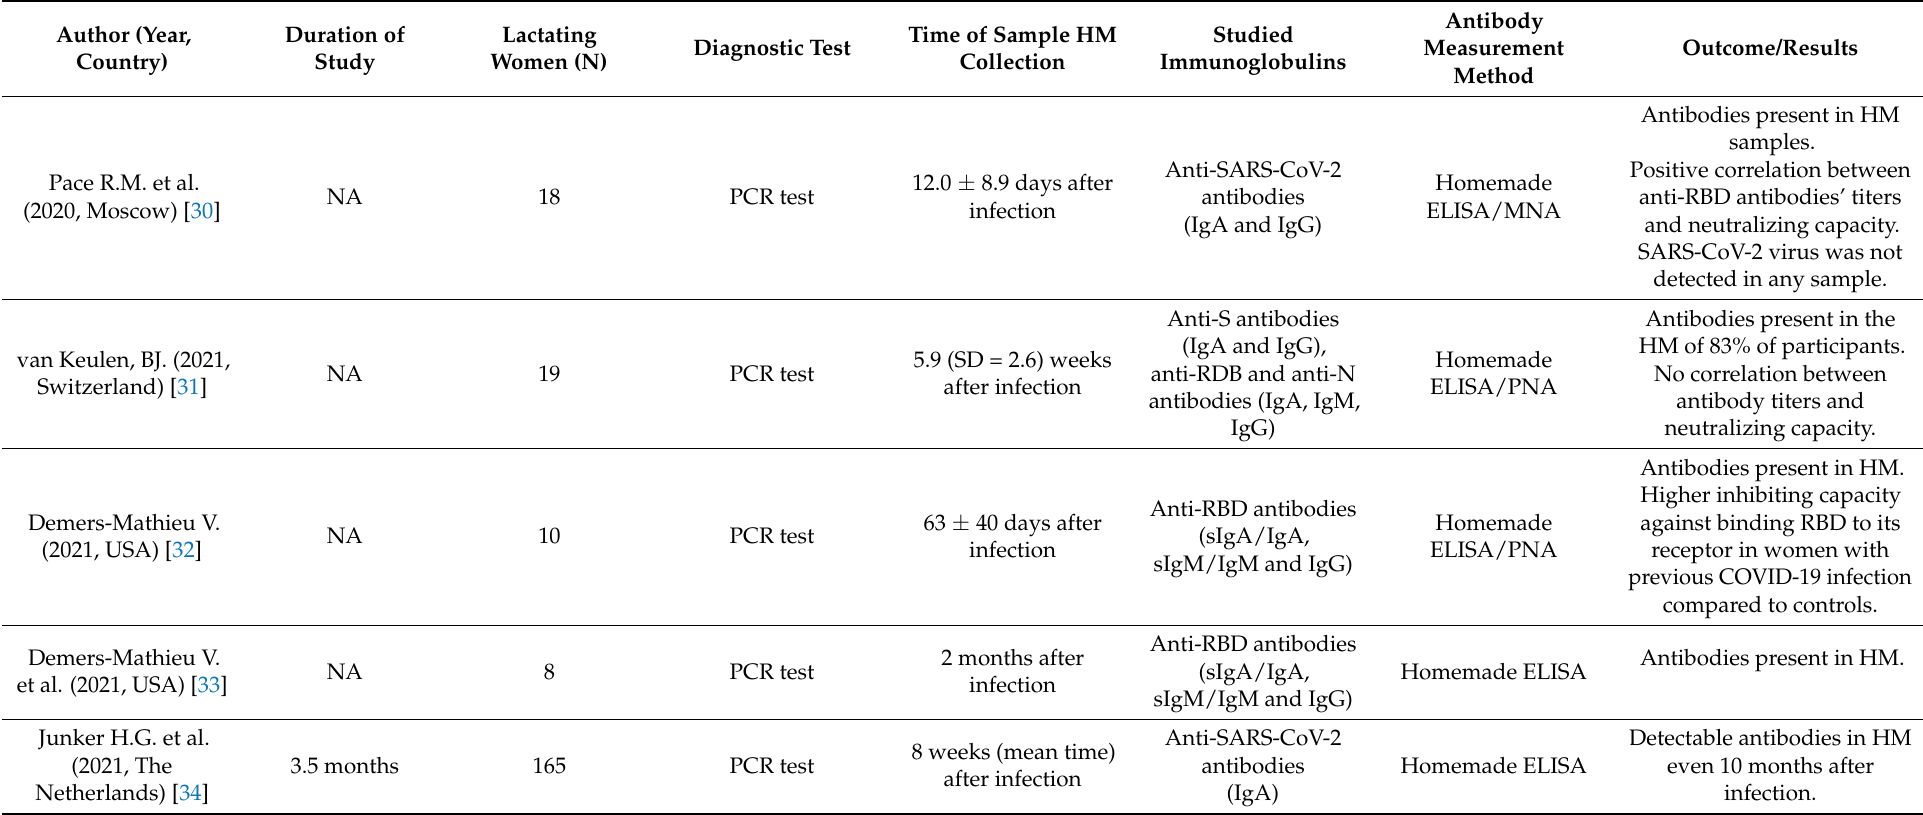
Table 2. Characteristics of included studies referring to first-time-infected lactating